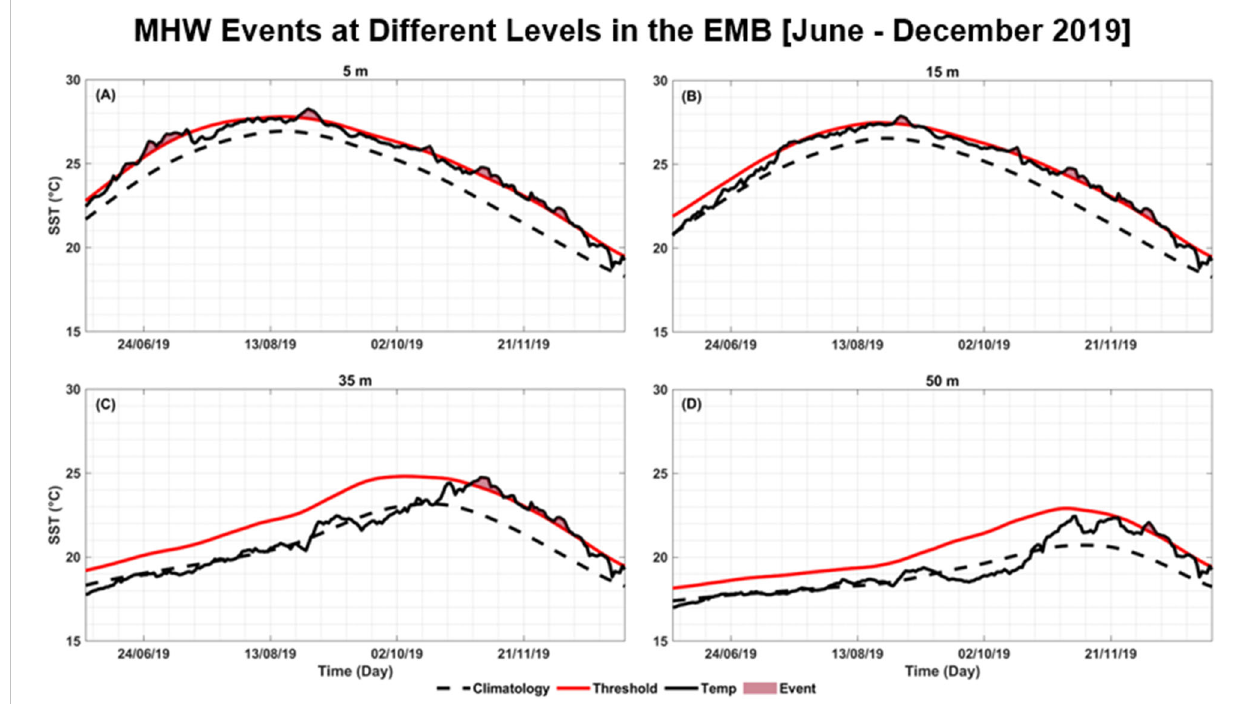
FIGURE 9 The penetration of MHW events into the water column in the EMB at different depths (A) 5m, (B) 15m, (C) 35m, and (D) 50m. The red shaded area refers to the MHW event. The black solid line represents the water temperature, the black dotted line represents the climatology, and the red solid line represents the